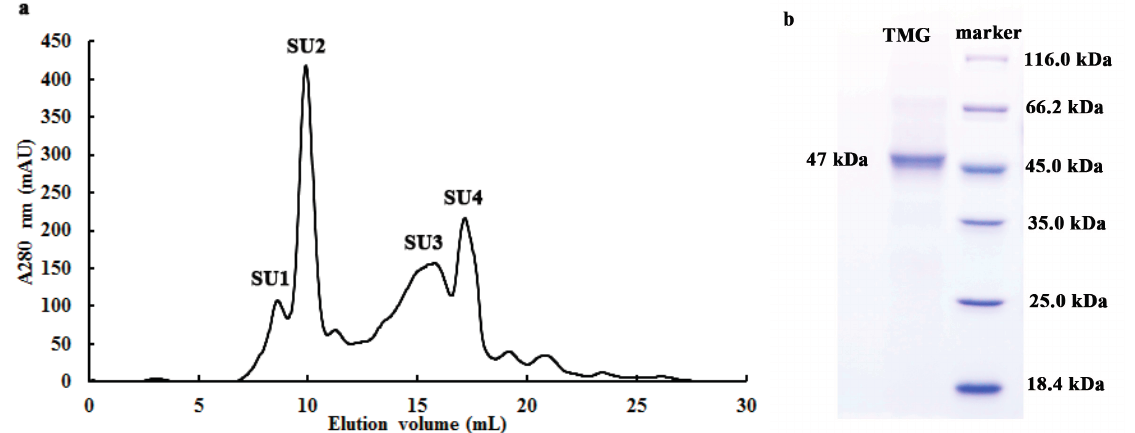
Figure 1. ( a ) FPLC-gel filtration on Superdex 75 10/300 GL column and ( b ) SDS-PAGE of fraction SU2. ( a ) Eluent: 10 mM NaOAC-HOAC buffer (pH 5.2). Fraction size: 0.8 mL; Flow rate: 0.5 mL·min − 1 . Fraction SU1 represents purified Tricholoma matsutake α -galactosidase; ( b ) SDS-PAGE of fraction SU2.